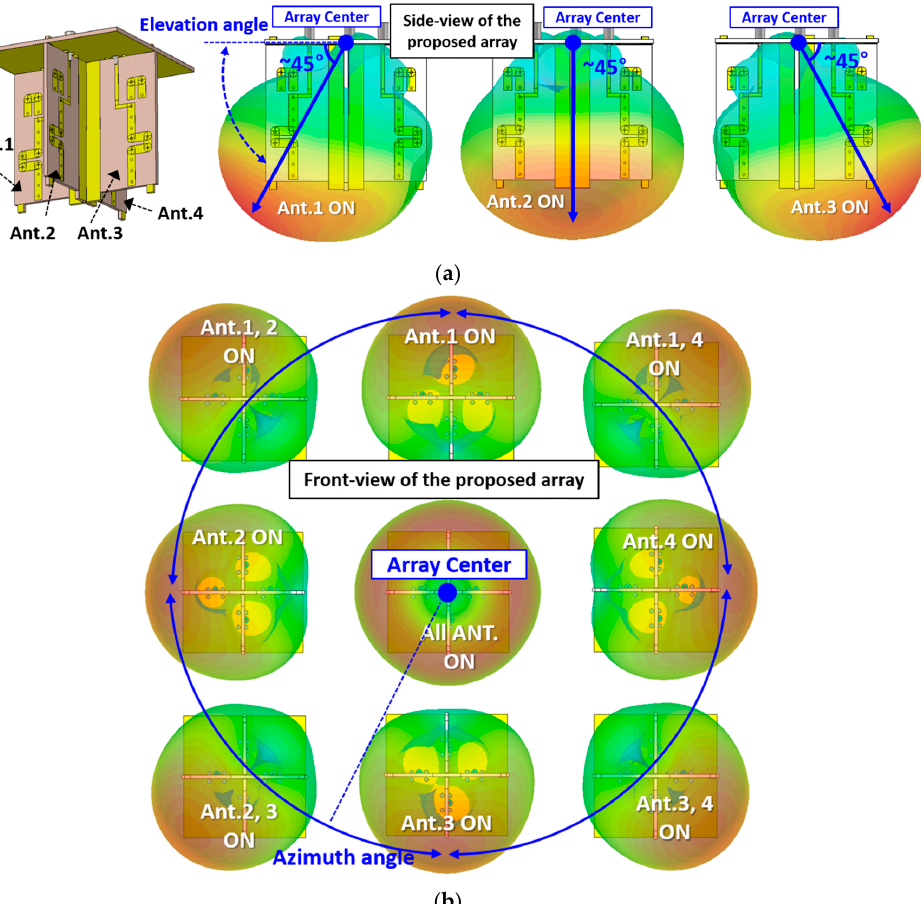
Figure 6. Simulated 3D radiation patterns of the proposed 1 × 4 array antenna in the ( a ) elevation angle and ( b ) azimuth angle.